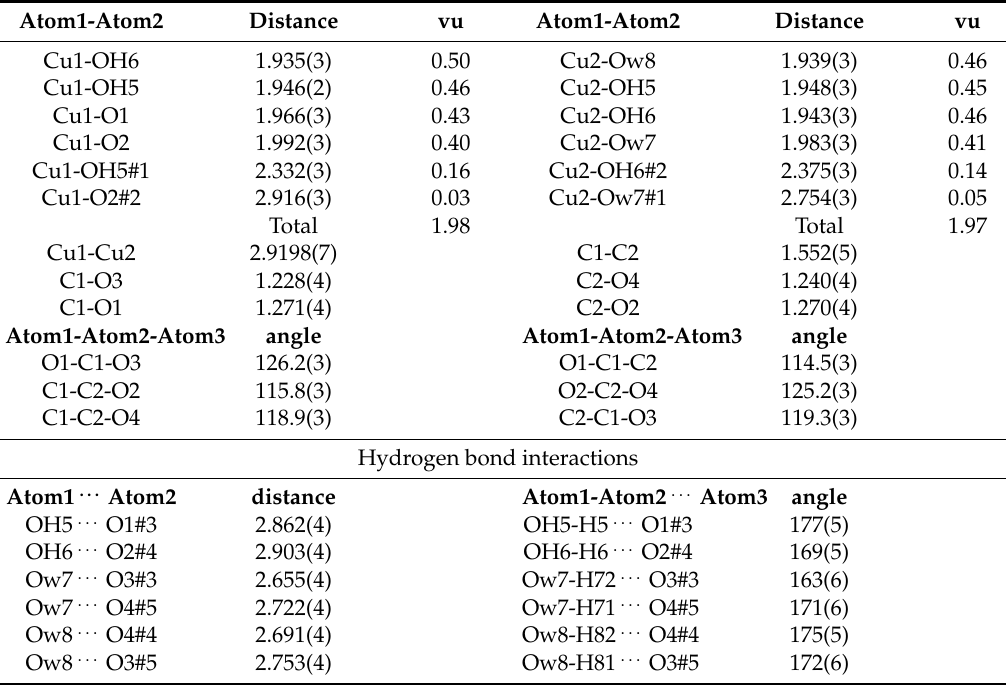
Table 5. Selected interatomic distances (Å), angles ( ◦ ) and bond-valence sums